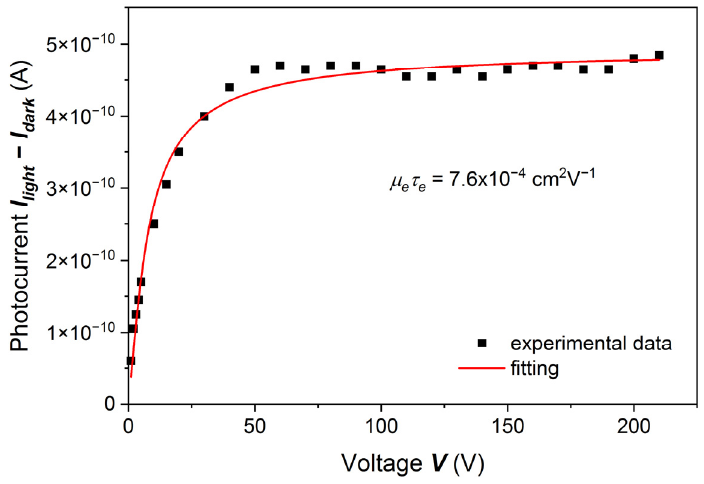
Figure 2. Room-temperature Am-241 gamma-ray response current for the (Cd,Mn)Te:In sample measured in Figure 1. Gamma radiation energy is 59.5 keV. The solid line is a fit with the Hecht equation, μ e τ e = 7.6 × 10 − 4 cm 2 V − 1 with a standard error of 0.44 × 10 − 4 cm 2 V − 1 .